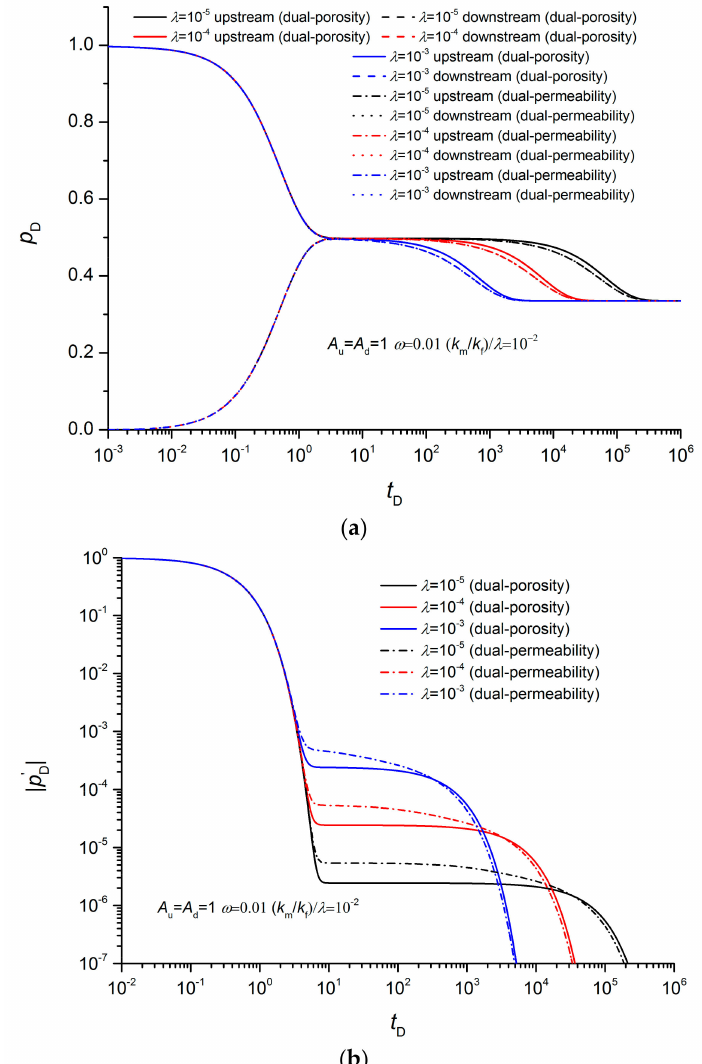
Figure 10. E ff ect of interporosity flow coe ffi cients on pulse decay test for dual-permeability cores (fixed matrix structure). ( a ) Pressure history. ( b ) Pressure derivative